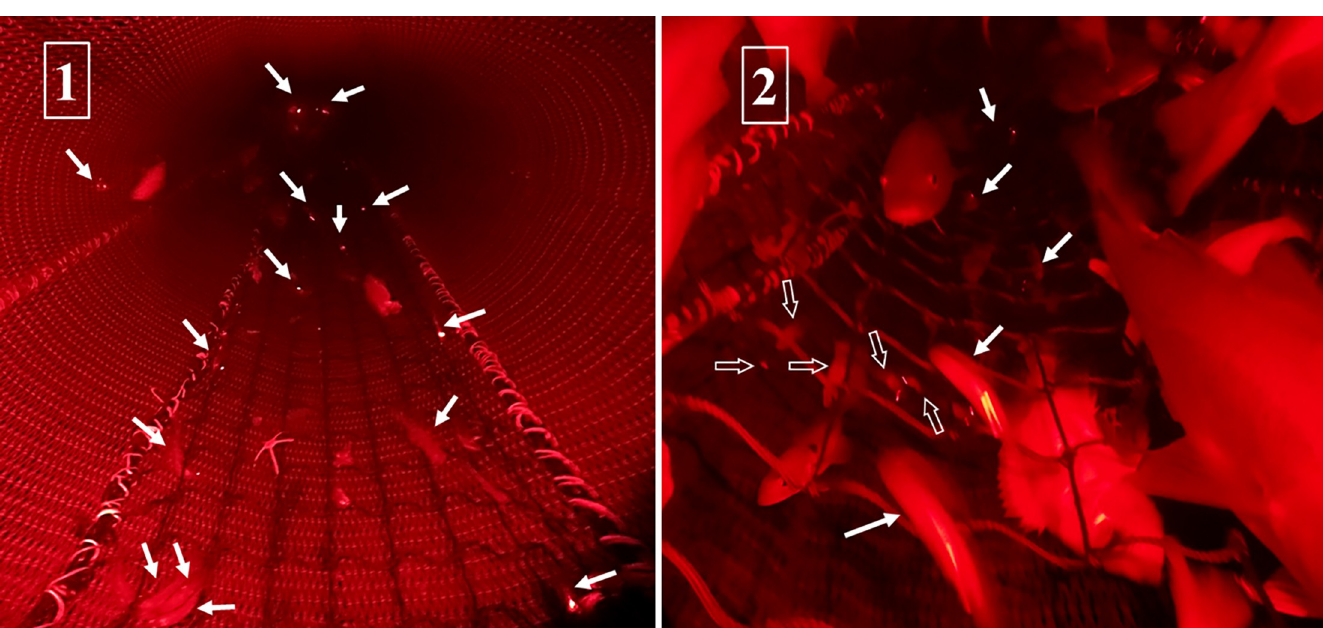
Fig 6. Photos taken from underwater recordings made during March 2017. Plate 1 shows the start (front) of the sieve panel. Solid white arrows indicate shrimp over the sieve panel. Plate 2 shows the aft part of the sieve panel close to the bycatch outlet. Hollow arrows indicate shrimp under the sieve